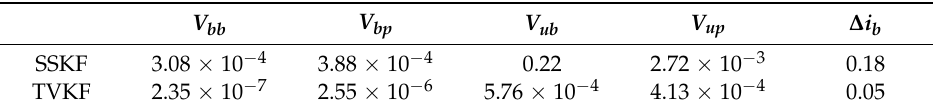
Table 5. Average states estimation errors of SSKF and TVKF.